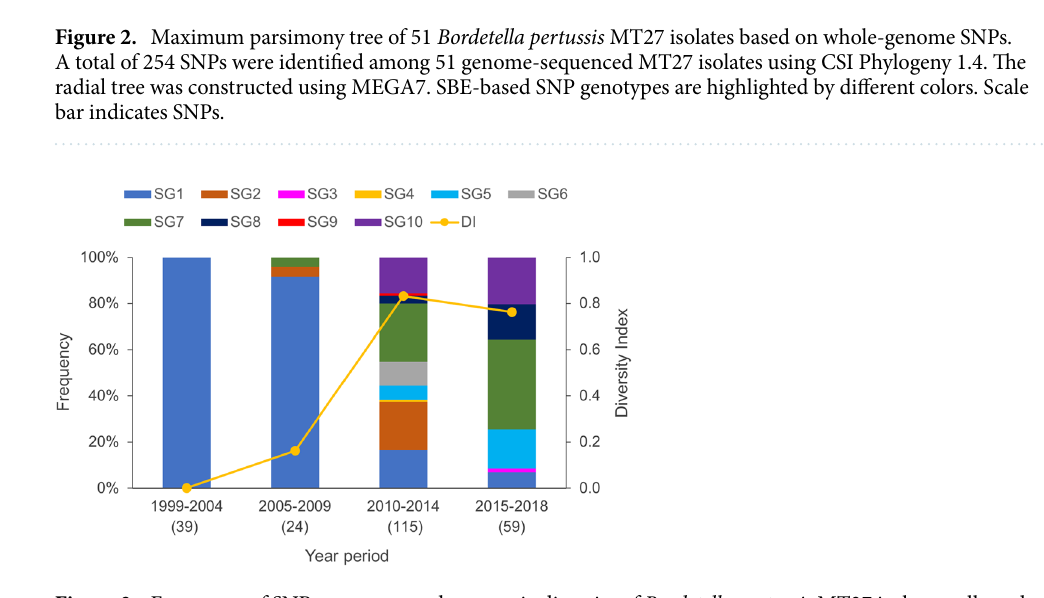
Figure 3. Frequency of SNP genotypes and genotypic diversity of Bordetella pertussis MT27 isolates collected in Japan during 1999–2018. Simpson’s diversity index (DI) was examined with the frequencies of SNP genotypes (SGs) within four time periods. Numbers in parentheses indicate the number of isolates